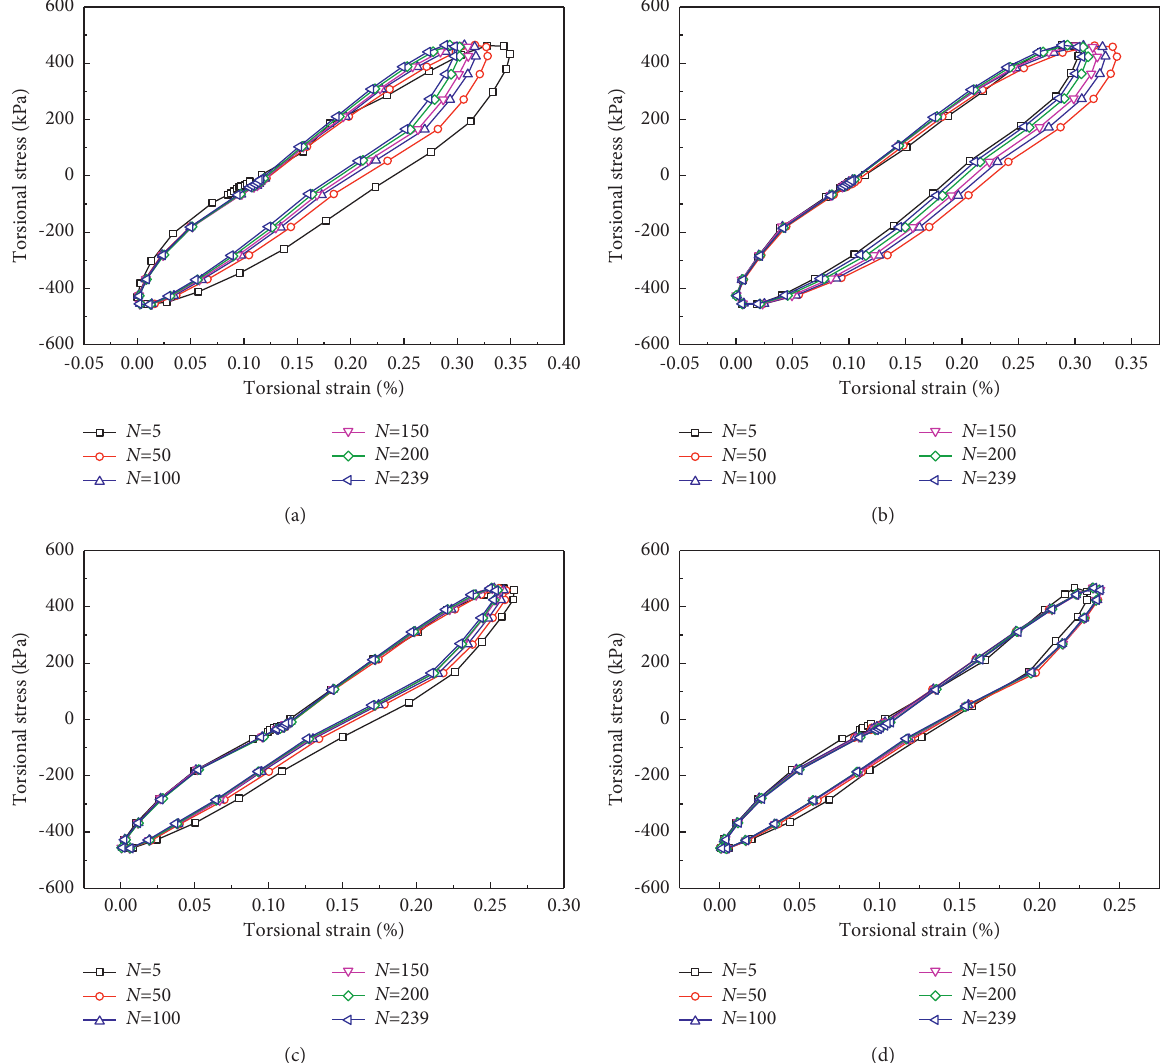
Figure 13: Representative torsional stress-strain responses for a given CSR under different temperatures. (a) T � − 8 ° C. (b) T � − 10 ° C. (c) T �− 13 ° C. (d) T � − 15 °